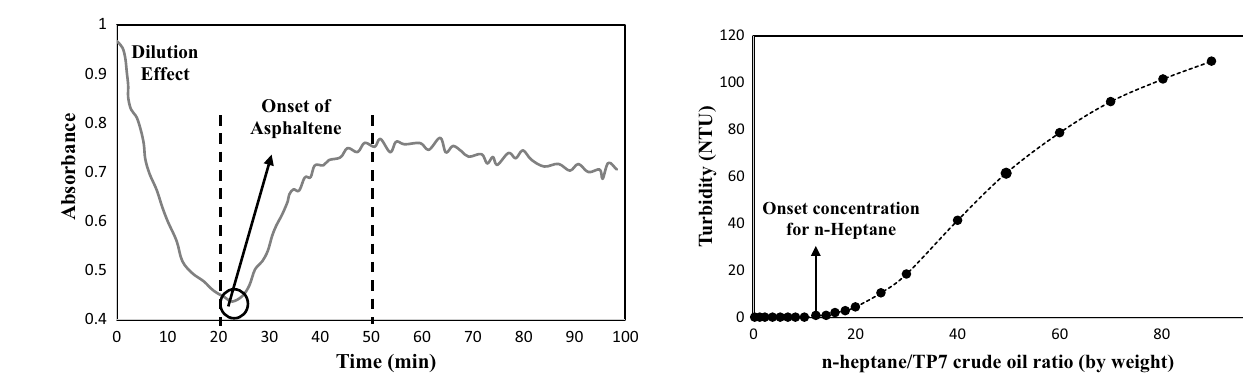
Fig. 29 Absorbance of NIR light versus duration of titration (Fuhr et al. 1991)